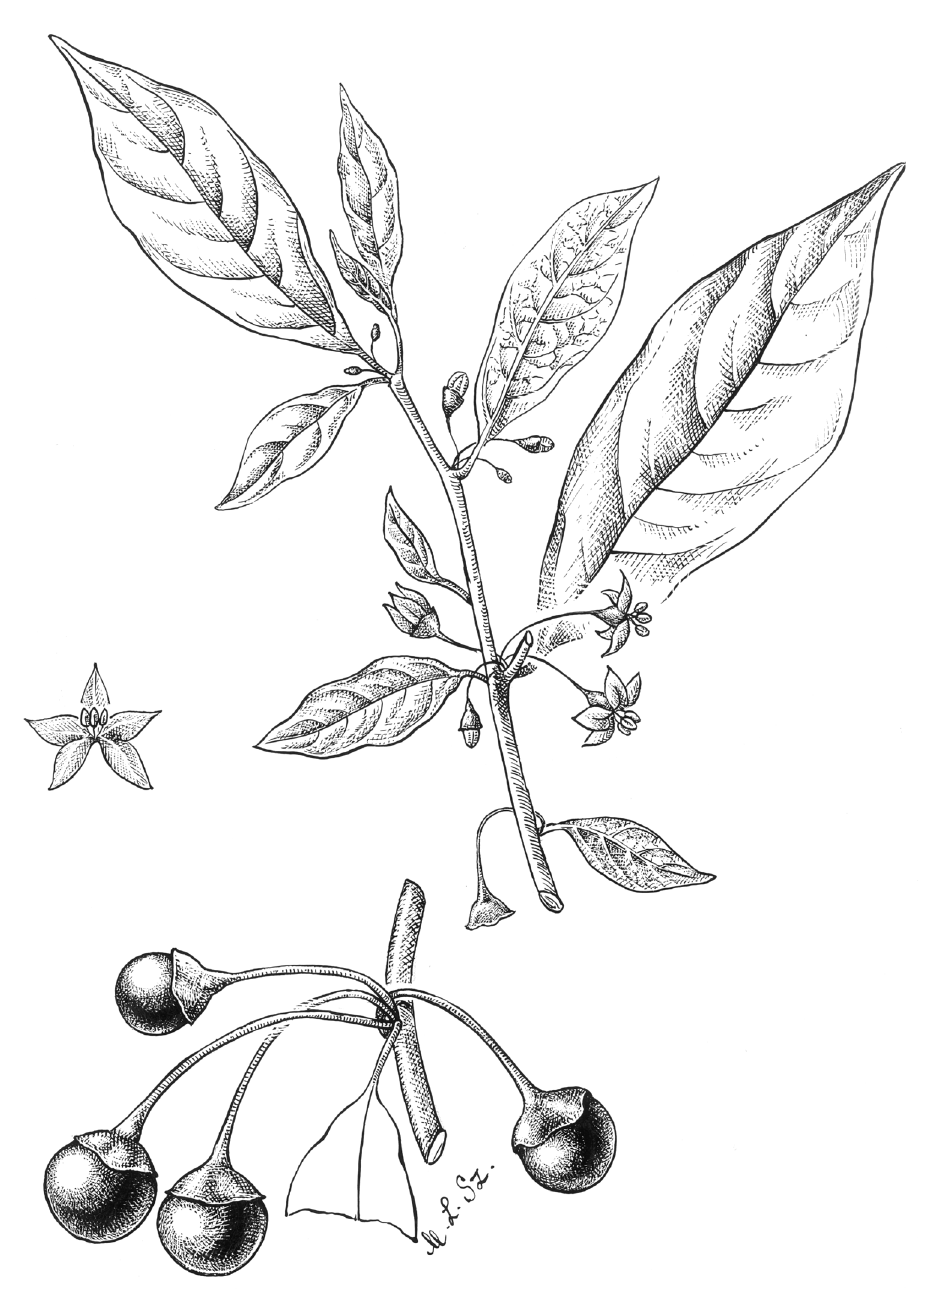
Figure 31. Lycianthes moszkowskii (Bitter) Bitter. Drawing by M.L. Szent-Ivany, first published in Symon (1985: fig. 15, as S. moszkowskii Bitter). Courtesy of the Board of the Botanic Gardens and State Herbarium (Adelaide, South Australia), reproduced with